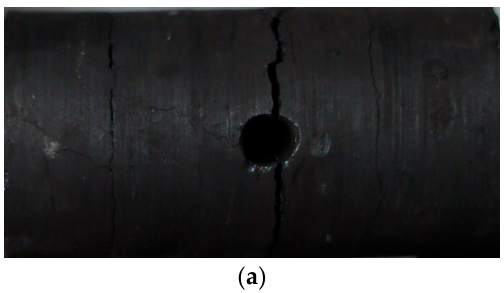
Figure 8. Comparison of failure modes between experiment and simulation (d = 8 mm, v = 4.2 m/s). ( a ) Experiment, ( b ) Simulation.